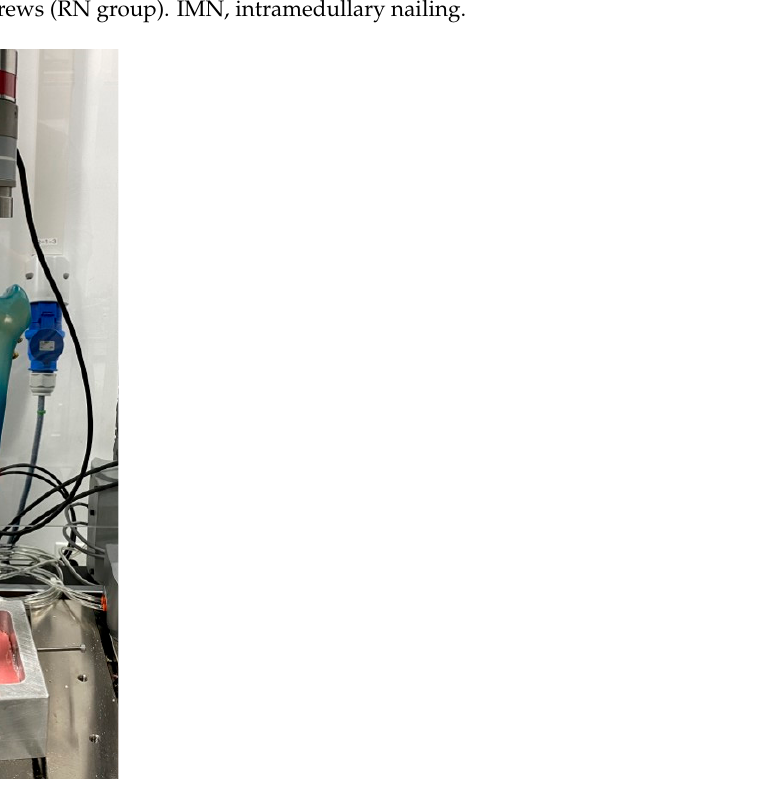
Figure 2. Experimental setup for measuring the stiffness and failure load after creating the osteoporotic femur models with different proximal interlocking screw constructs.